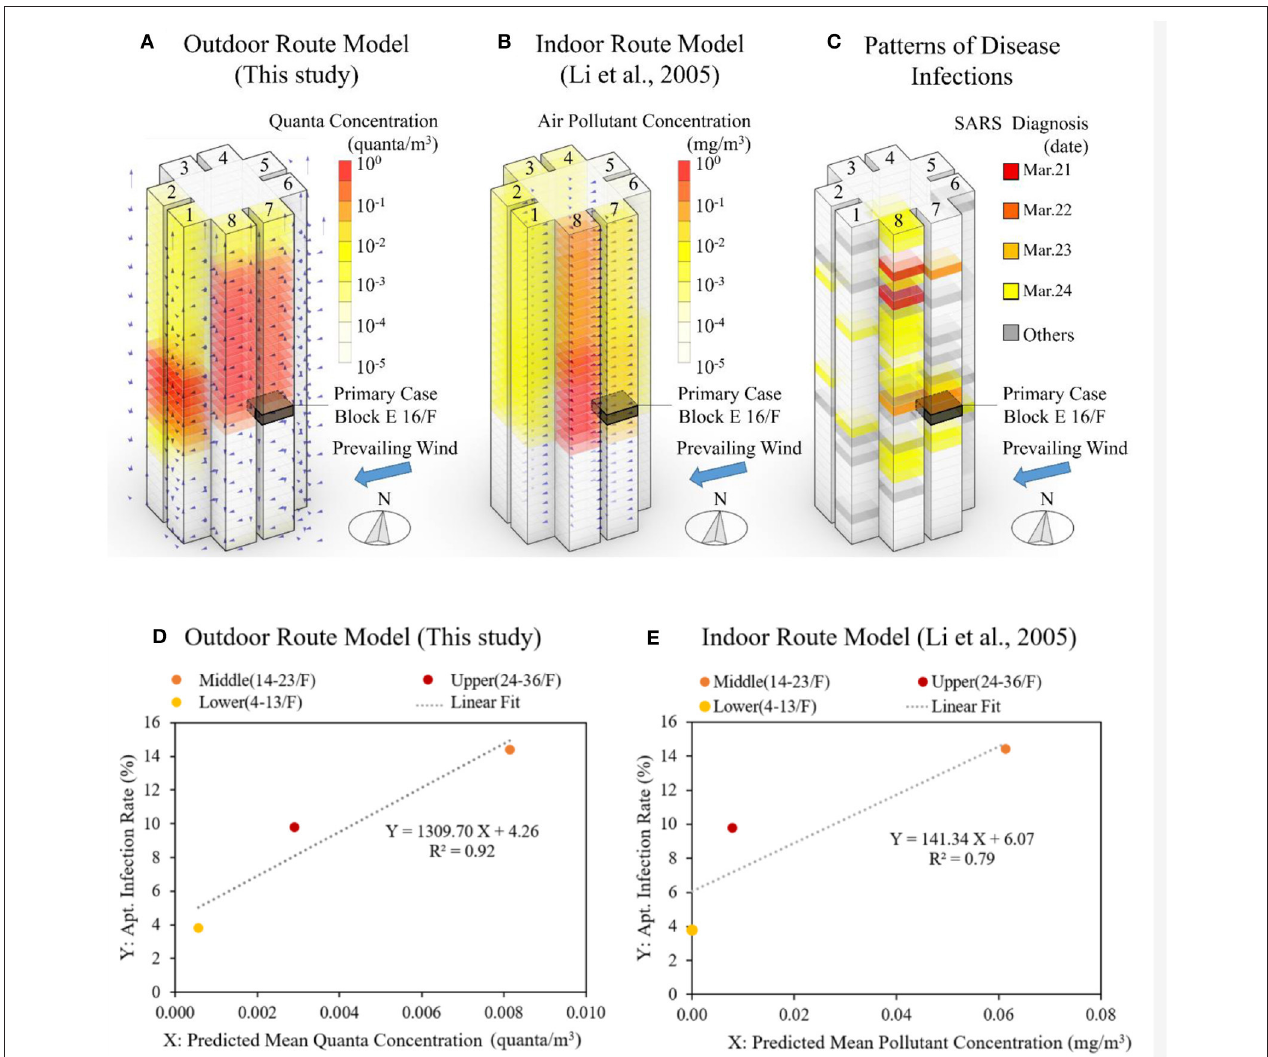
FIGURE 12 | (A) Predicted quanta concentration via the outdoor route using the ATOR model; (B) predicted air pollutant concentration via the indoor route using a detailed multizone model by Li et al. (2005); (C) SARS diagnosis in Block E of Amoy Gardens at apartment level; (D) percentage of infected apartments in Block E of Amoy Gardens vs. the predicted mean quanta concentration for the outdoor route model; and (E) the air pollutant concentration using the indoor route model ( Li et al., 2005, p. 22); values are aggregated by the lower, middle, and upper proportion of